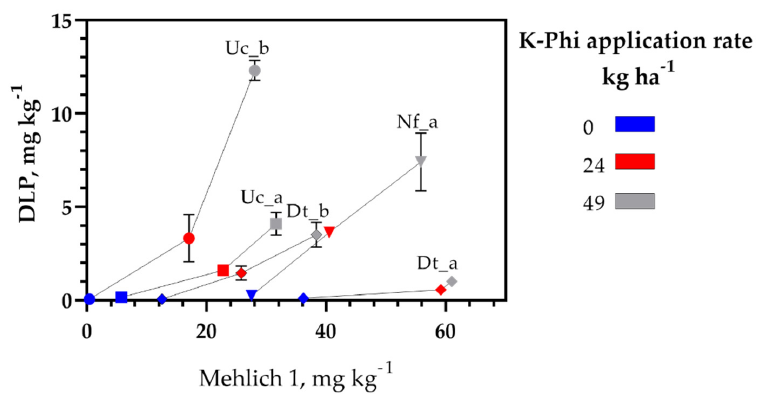
Figure 3. Relationship between mean Mehlich 1 soil P (Phi + Pi) and cumulative dissolved leached P (DLP = Phi + Pi) for each of the five soils in this study (Dt_a, Dt_b, Nf_a, Uc_a, Uc_b) at three application rates of potassium phosphite (K-Phi). Error bars are one standard deviation of the mean. Given the significant high correlation between WSP and DLP (Table 3), we combined the five soil datasets used in the regression analyses to assess the potential Phi and Pi leaching losses due to soil Phi saturation using the PSR approach. A low PSR (< 0.06) for the controls (no Phi applied) of Dt_b, Uc_a, and Uc_b (Figure 4, blue dataset) is related to